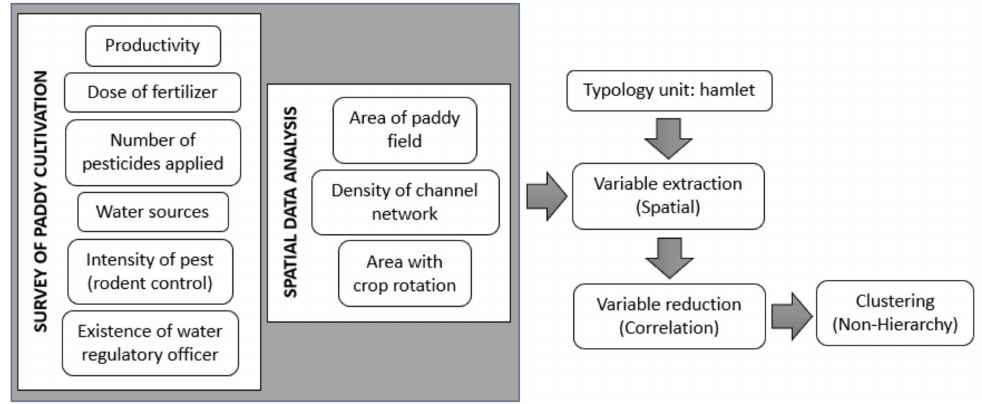
Figure 5. Flow diagram of cluster analysis to develop paddy farming